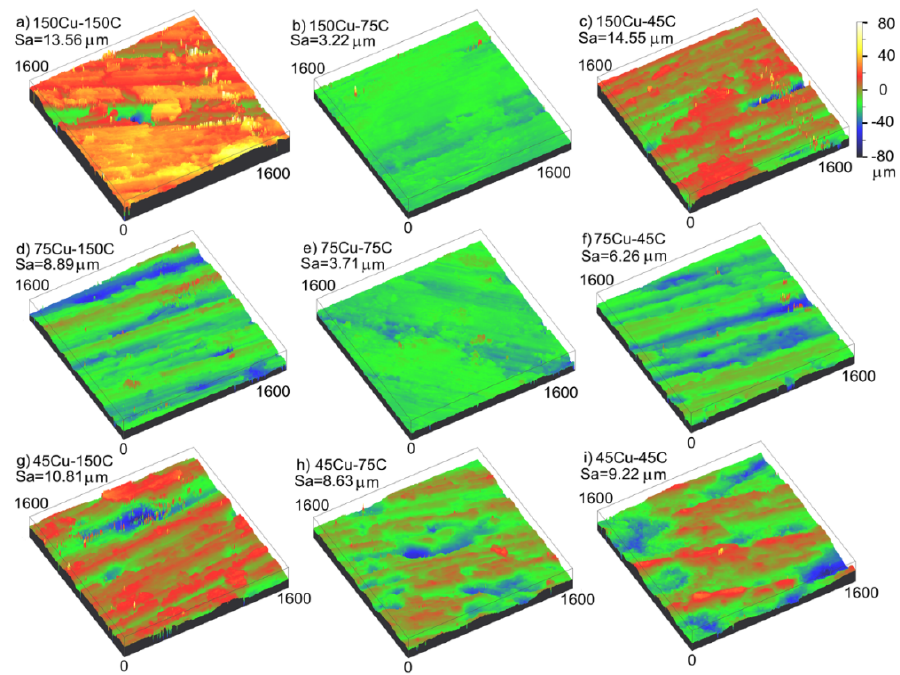
Figure 7. The three-dimensional morphology and surface roughness of the mechanical wear area: ( a ) 150 µ m copper–150 µ m graphite, ( b ) 150 µ m copper–75 µ m graphite, ( c ) 150 µ m copper–45 µ m graphite, ( d ) 75 µ m copper–150 µ m graphite, ( e ) 75 µ m copper–75 µ m graphite, ( f ) 75 µ m copper–45